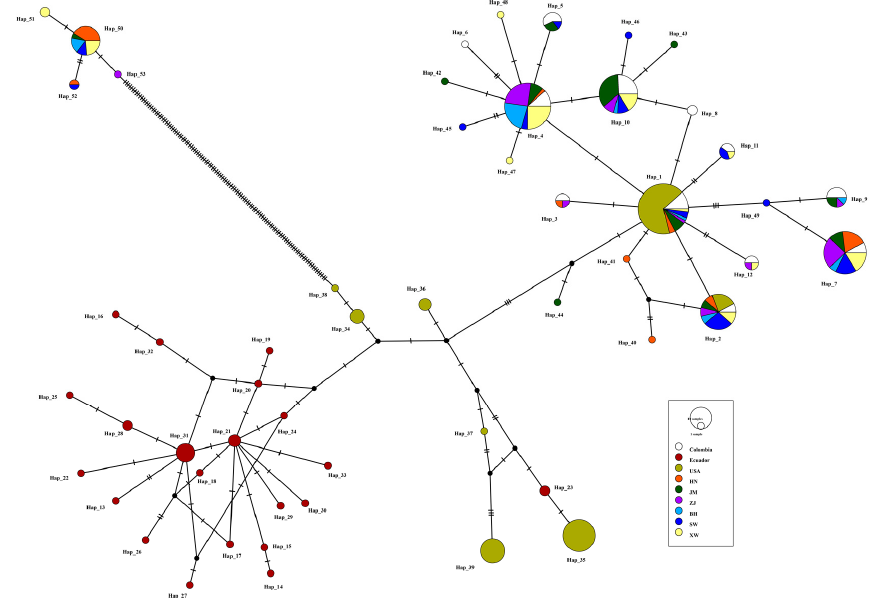
Figure 3. A TCS network showing the genetic relationships for the mitochondrial COI gene fragment among nine populations of Mytella strigata in China, the United States, Colombia, and Ecuador. The cluster of the male lineage of Hap_50–53 is on the upper left, and the other haplotypes are of female lineage.